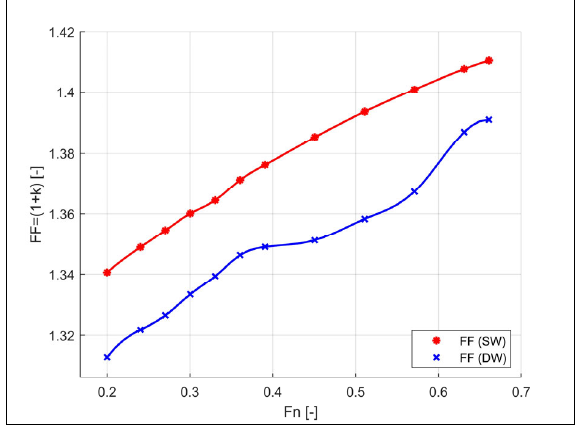
Figure 14. Form factors in deep and shallow water conditions.